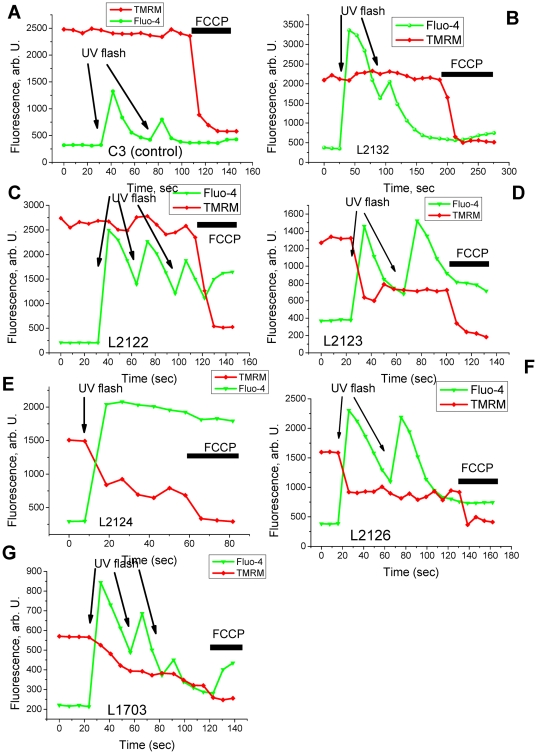
A rise in [Ca2+]c induces mitochondrial depolarisation in fibroblasts with PINK1 mutations.Arrows mark UV-induced flash photolysis of cells loaded with Ca-NP-EGTA, fluo-4 and TMRM. In control C3 (A), L2132 (B) and in fibroblast with L2122 mutation (C) demonstrated an increase in [Ca2+]c in response to flash photolysis, with no change in Δψm. In fibroblasts with PINK1 mutations (L2123 –D; L2124 – E; L2126 – F; and L1703-G), flash photolysis induced an increase in [Ca2+]c with profound depolarisation of the mitochondria.